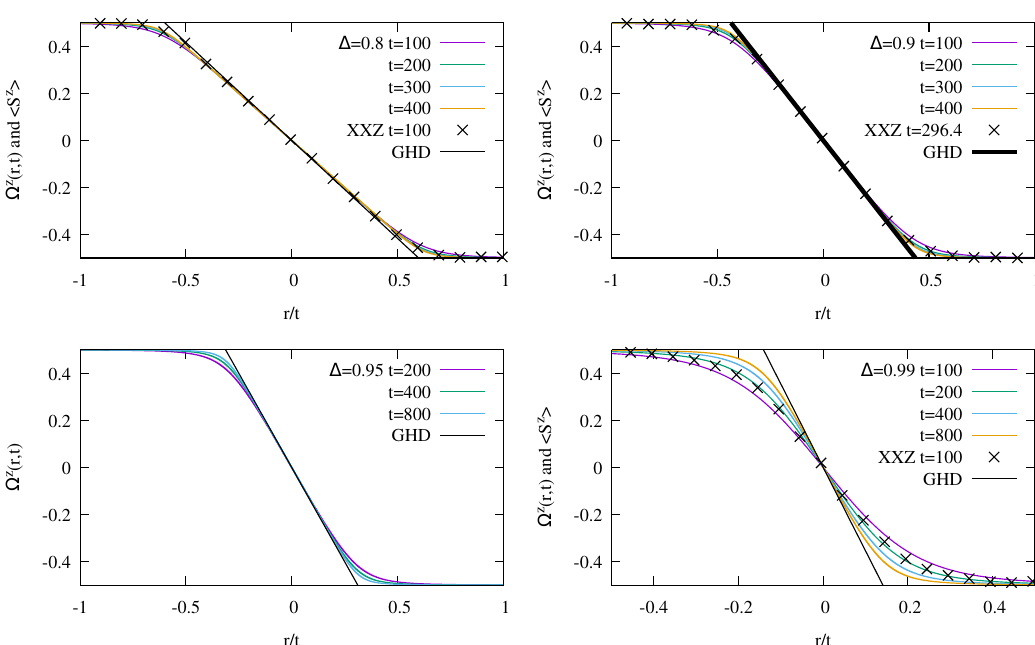
Figure 3: Ω z ( r , t ) from the solution of the classical LL equation, as a function of the rescaled position r / t for ∆ = 0.8, ∆ = 0.9, ∆ = 0.95 and ∆ = 0.99 and for different times from t = 100 to t = 800. The black lines, labeled GHD, represent the long-time limit of the profile for the XXZ chain, 〈 S z 〉 = − r as predicted by GHD. In the panels associated to ∆ = 0.8,9 and ∆ = 0.99, the black crosses represent tDMRG data for the XXZ